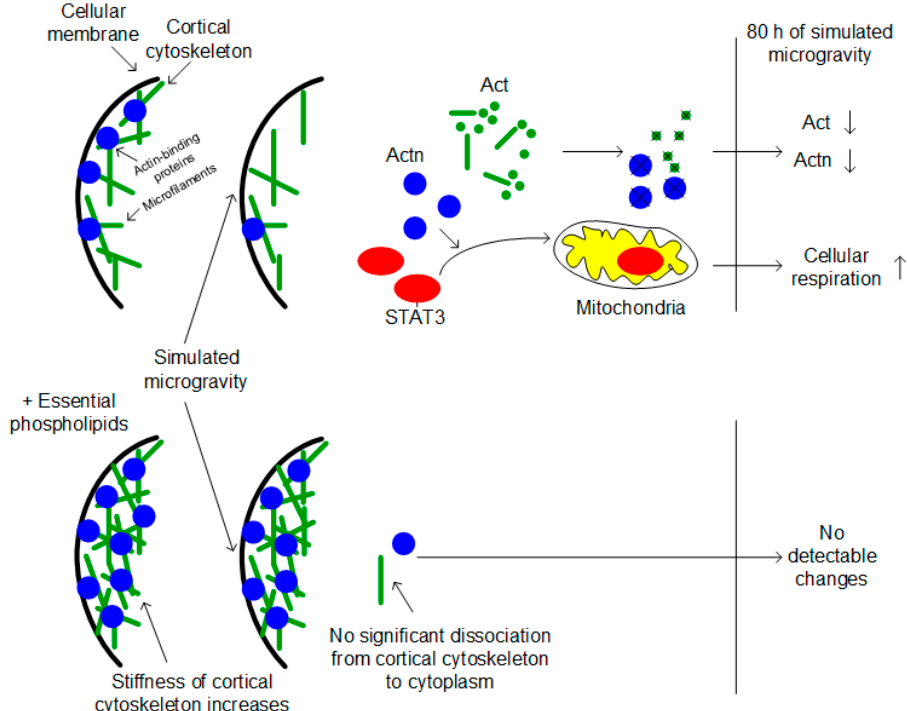
Figure 5. Hypothesis of the possible mechanism of increasing cellular respiration of Drosophila ovaries after full cycle of oogenesis under simulated microgravity. Changes of the external mechanical load leads to cortical cytoskeleton deformation and migration actin-binding proteins and actin filaments to the cytoplasm. Actin-binding proteins, particularly alpha-actinin Actn, recruits factor STAT3. It migrates to the mitochondria and activates cellular respiration. The administration of the essential phospholipids increases stiffness of the cortical cytoskeleton and prevents deformation under changes of the mechanical load.